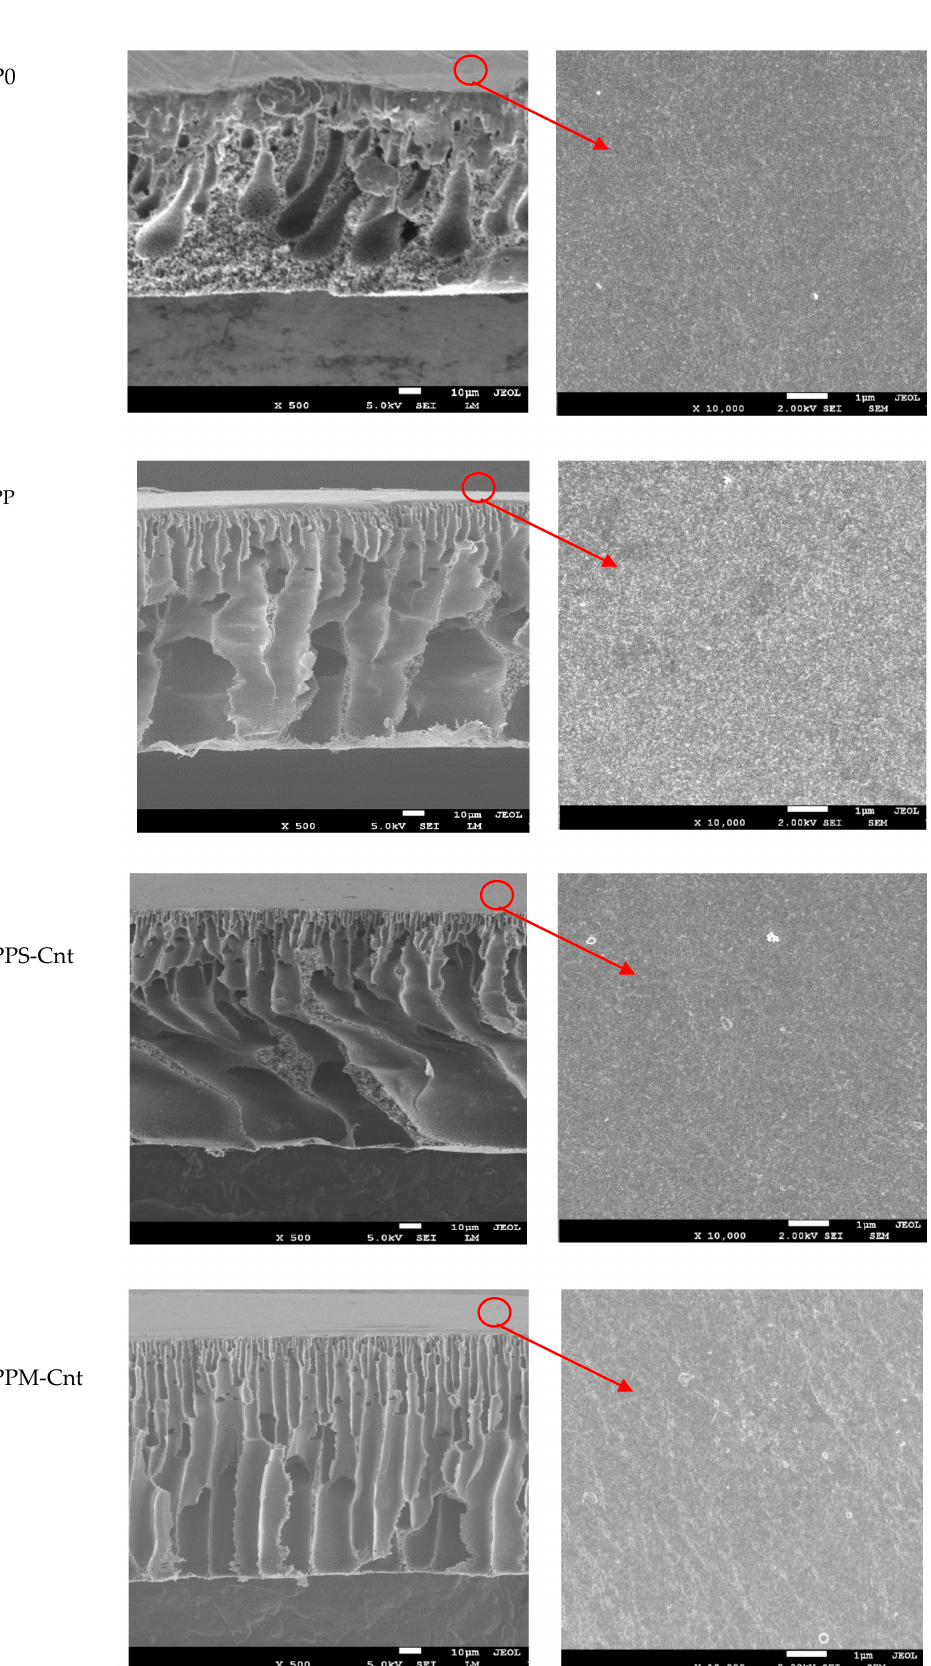
Figure 2. Membrane morphology analyzed by SEM.